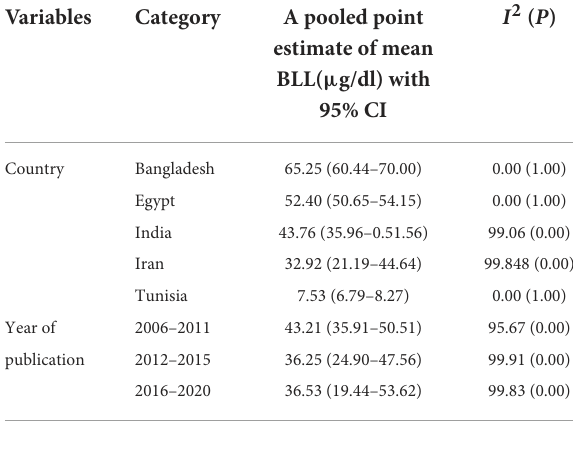
TABLE 2 Pooled mean of blood lead level, 95% CI, and heterogeneity estimate with a p -value and I 2 for the subgroup analysis.